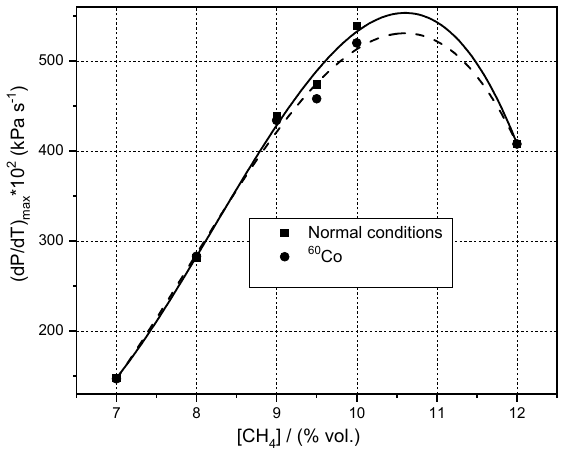
Figure 11. Experimental maximum rate of pressure rises for CH 4 –air mixtures at ambient initial conditions and in the presence of 60 Co.